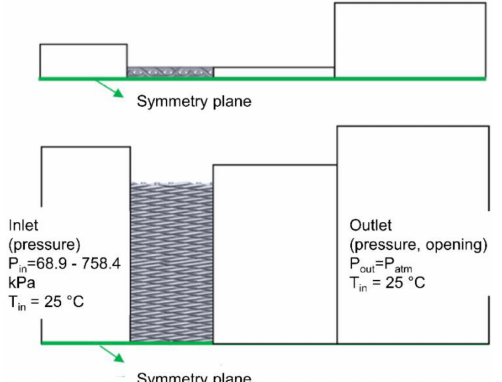
Figure 7. CFD model domain and boundary conditions for in-plane directions of warp, shute, and